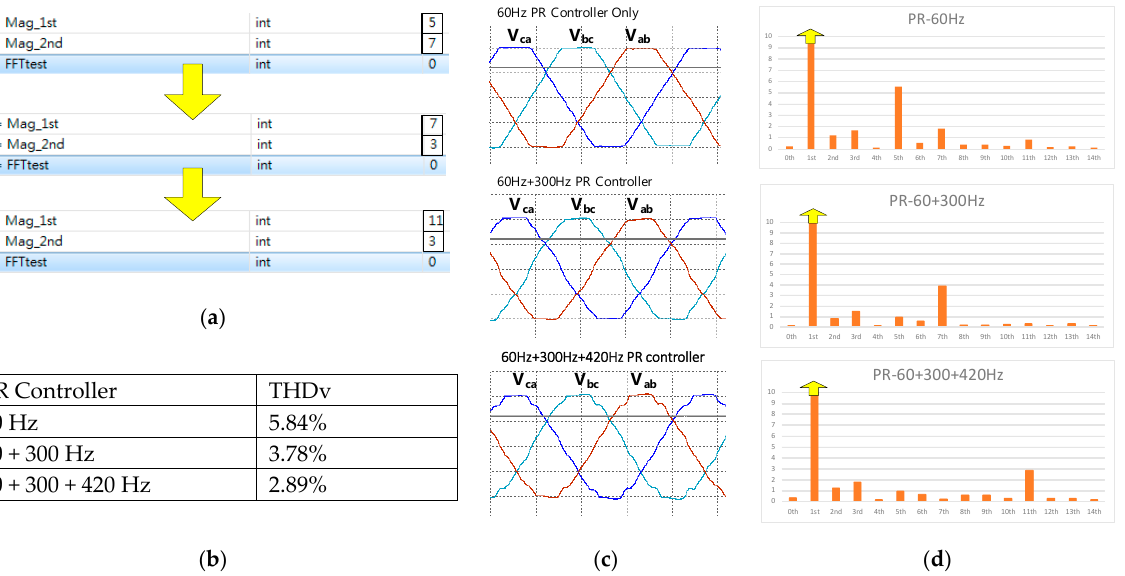
Figure 21. Nonlinear load (three-phase full bridge rectifier) compensated by different PR controllers ( a ) harmonics identification using FFT algorithm ( b ) THDv ( c ) voltage waveforms ( d ) voltage har- monic spectra measured from power analyzer.